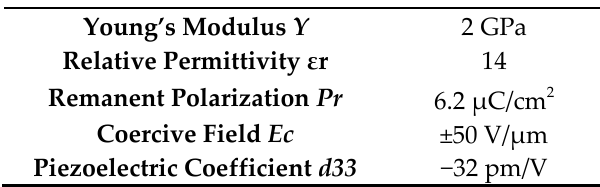
Table 1. Characterisitic material parameters of the ferroelectric polymer P(VDF 70 -TrFE 30